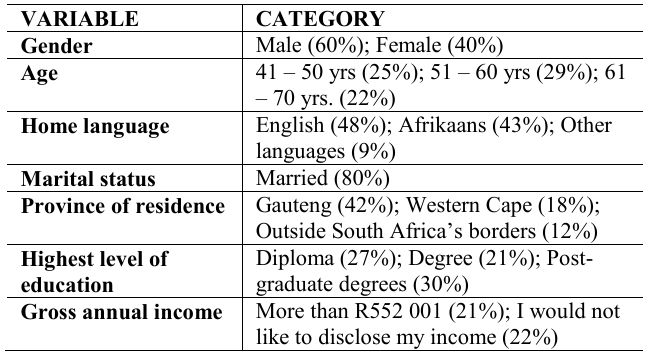
Table 1: Demographic profile of respondents